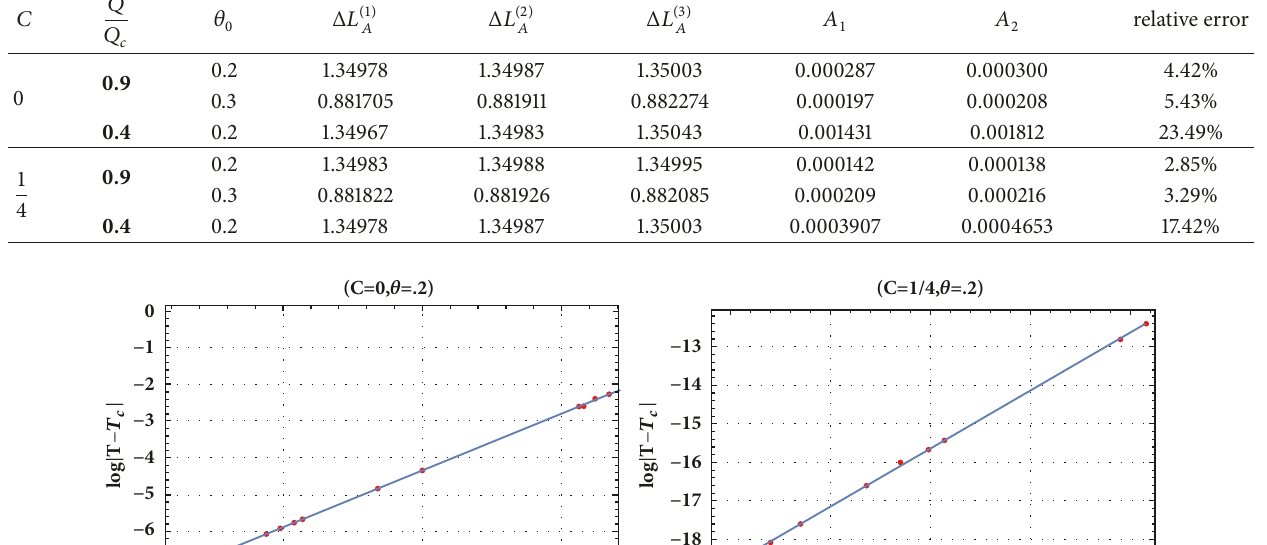
Figure 5: The relation between log |𝑇 − 𝑇 𝑐 | and log |Δ𝑆 𝐴 − Δ𝑆 𝐴